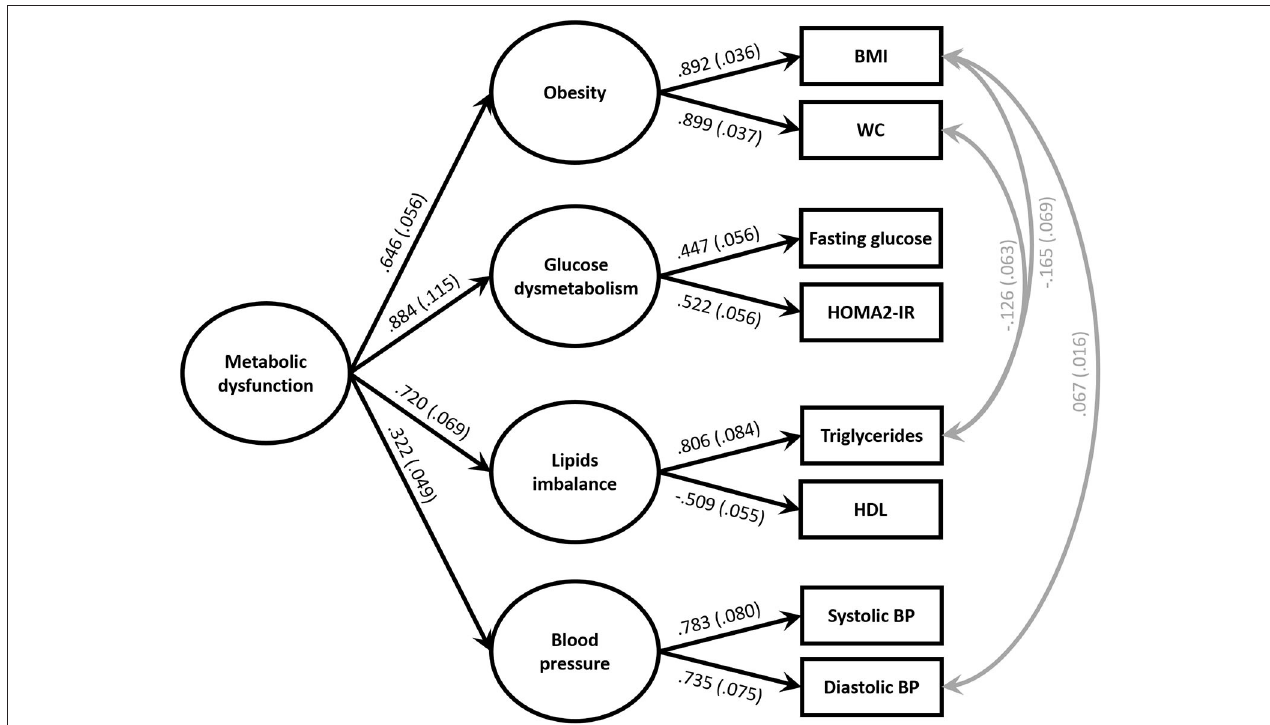
FIGURE 2 | Model of the metabolic dysfunction at baseline. χ 2 (13) = 40.762; p < 0.001, comparative fit index (CFI) = 0.981, Tucker Lewis Index (TLI) = 0.958 and root mean square error approximation (RMSEA) = 0.048; p = 0.564. Standardized parameter estimates representing factor loadings are shown on paths. All coefficients are significant at p > 0.01 for the two-tailed test. To maintain presentation clarity, residual terms are not shown. BMI, body mass index; WC, waist circumference; HDL, high density lipoprotein; BP, blood pressure.